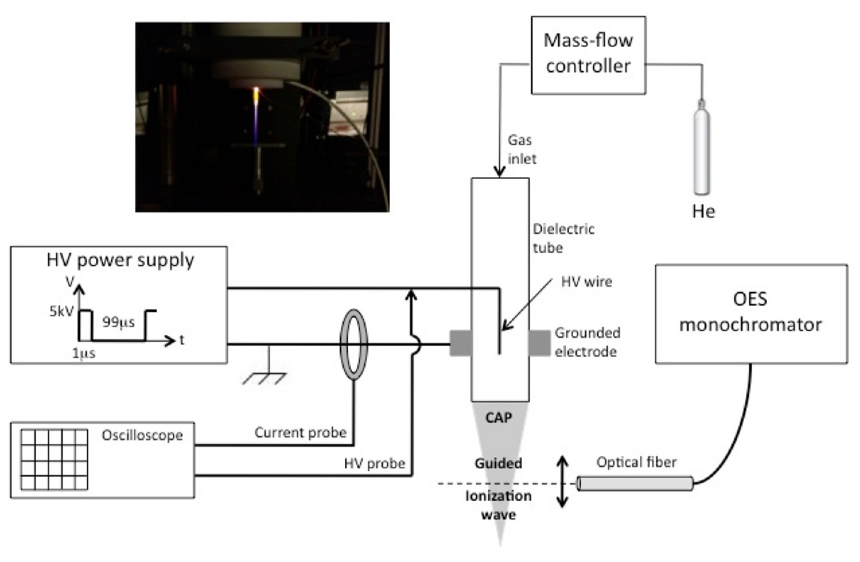
Fig 1. Experimental set-up.